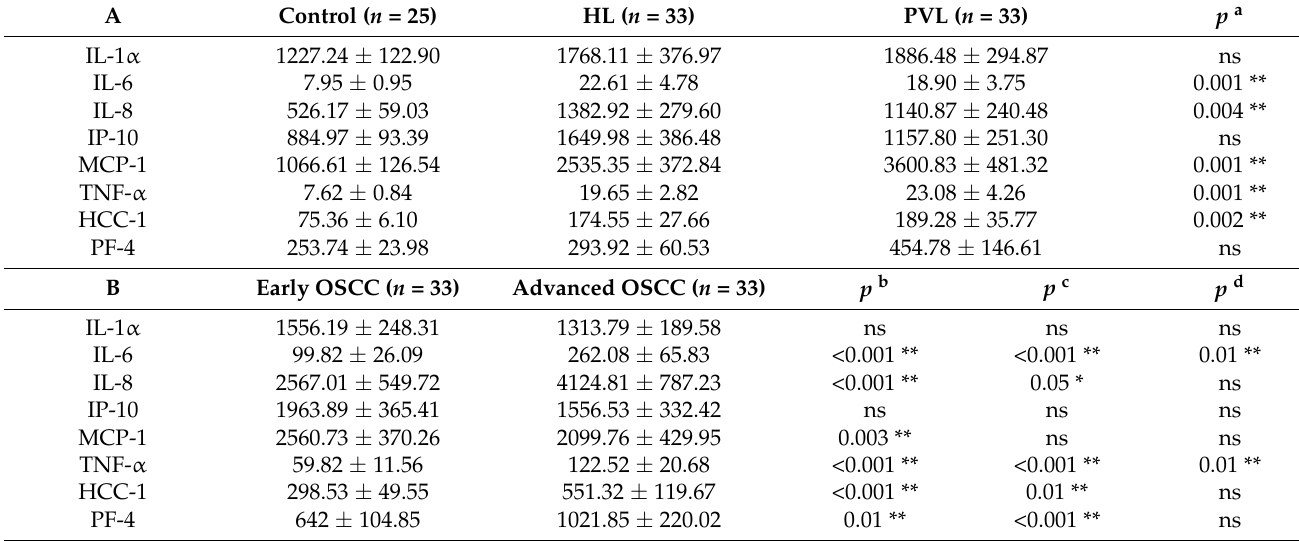
Table 2. Cytokine concentrations (pg/mL) in saliva samples of ( A ) control subjects, patients with HL and PVL, and ( B ) at early and advanced OSCC stages; values are expressed as the arithmetic mean ± standard error of the mean (SEM).